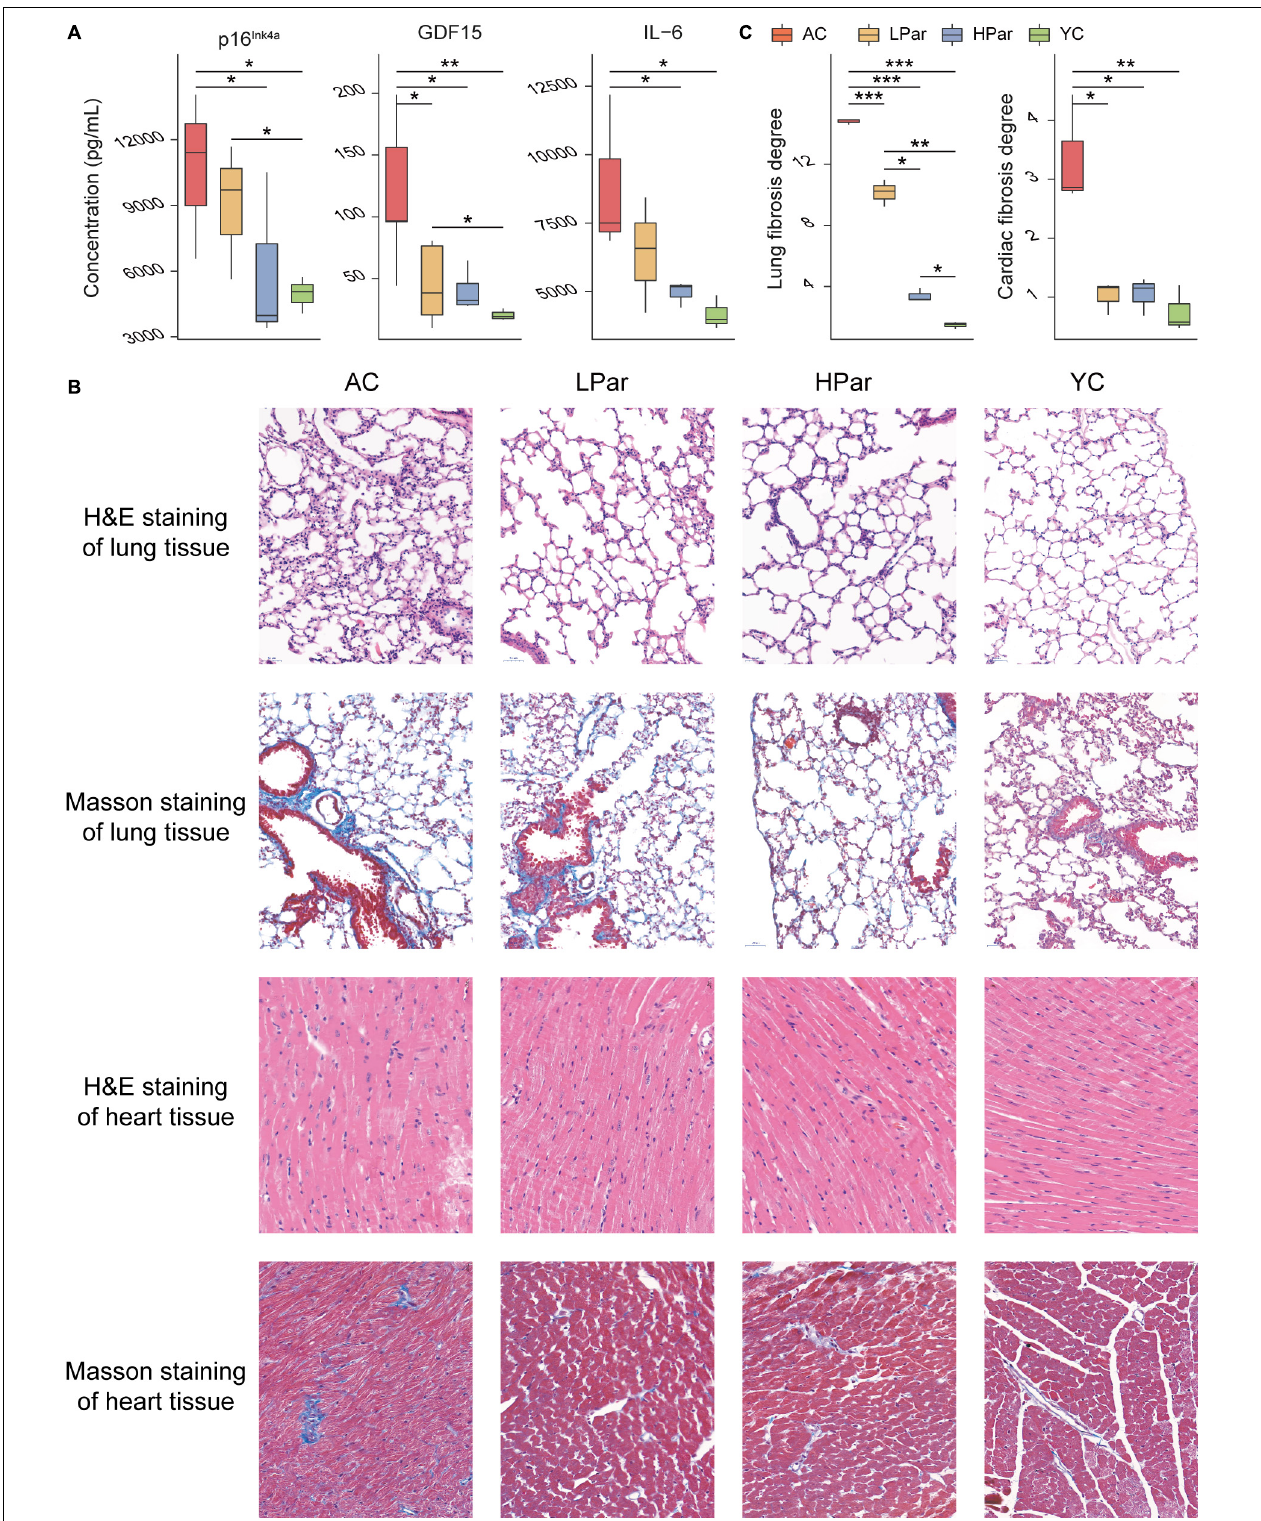
FIGURE 1 | Parishin treatment alleviates aging-induced abnormal blood indicator levels and cardiopulmonary injury. (A) Serum p16 Ink 4 a , GDF15, and IL-6 levels. (B) Representative images of lung and heart samples stained by H&E and Masson’s trichrome. (C) Fibrosis degree of lung and heart samples. * P < 0.05; ** P < 0.01; *** P <